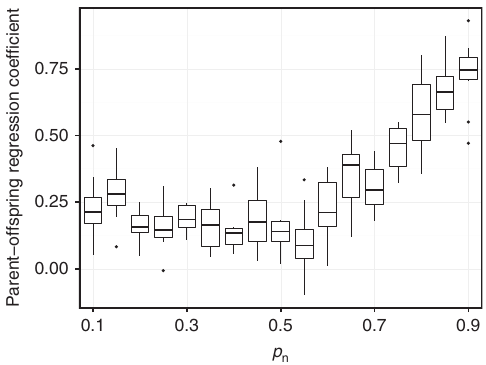
Figure 4 | Heritability as a consequence of social inheritance. The regression of betweenness centrality among parents and their offspring as a function of the strength of social inheritance ( p n ). The bottom and top of the box mark the first and third quartiles, respectively. The upper whisker extends from the hinge to the highest value that is within 1.5 (cid:3) IQR of the hinge, where IQR is the inter-quartile range, or distance between the first and third quartiles. The lower whisker extends from the hinge to the lowest value within 1.5 (cid:3) IQR of the hinge. Data beyond the end of the whiskers are outliers and plotted as points. Ten replications were run for each p n value. Parameter values: simulation steps ¼ 2,000, N ¼ 100, p r ¼ 0.01. we observe that the assortativity coefficient is significantly higher than in random networks, in which the trait values were re-assigned randomly (Fig. 5).